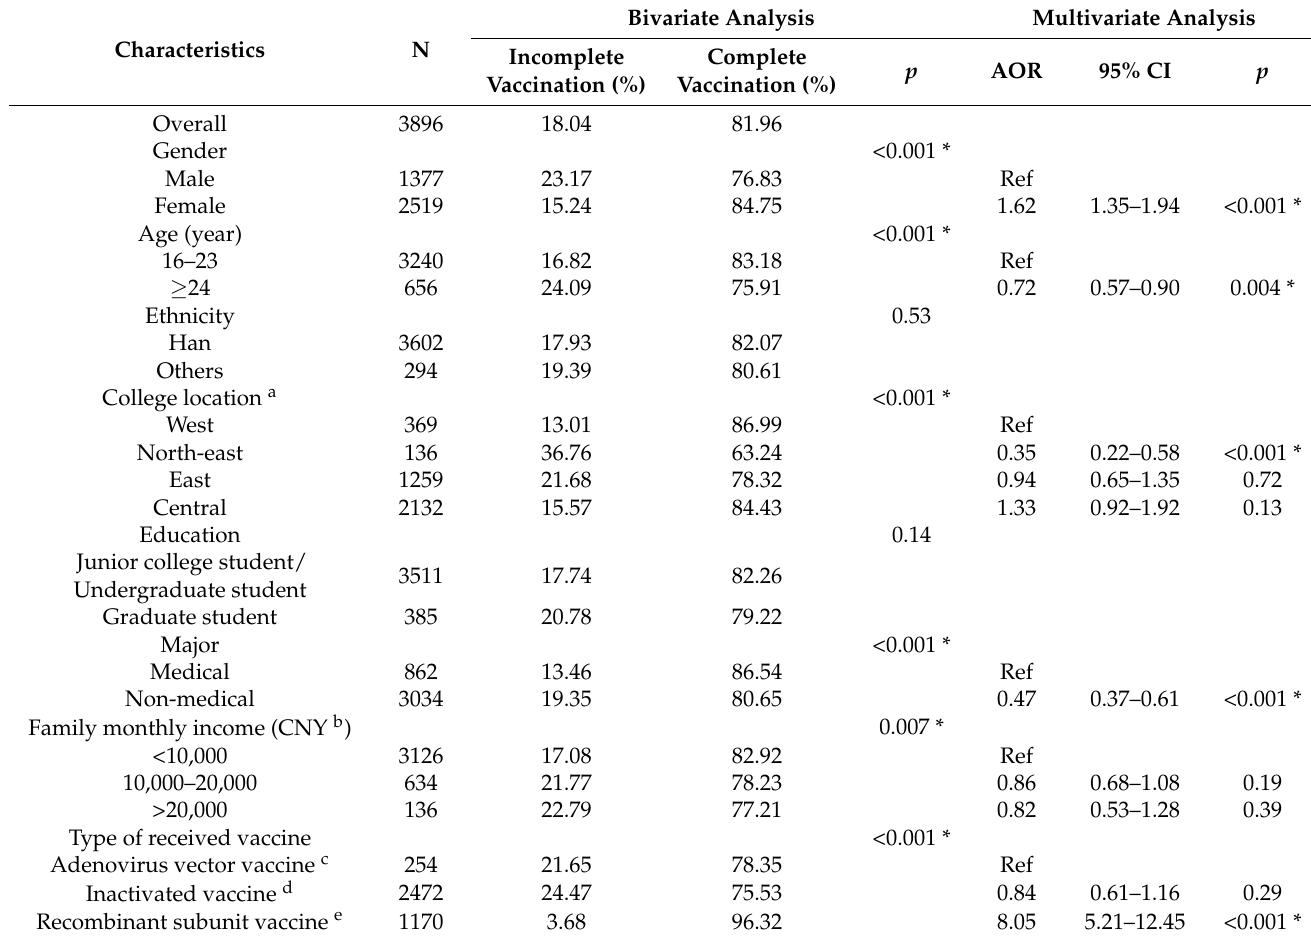
Table 2. Completion of the COVID-19 vaccination among Chinese college students (N = 3896).